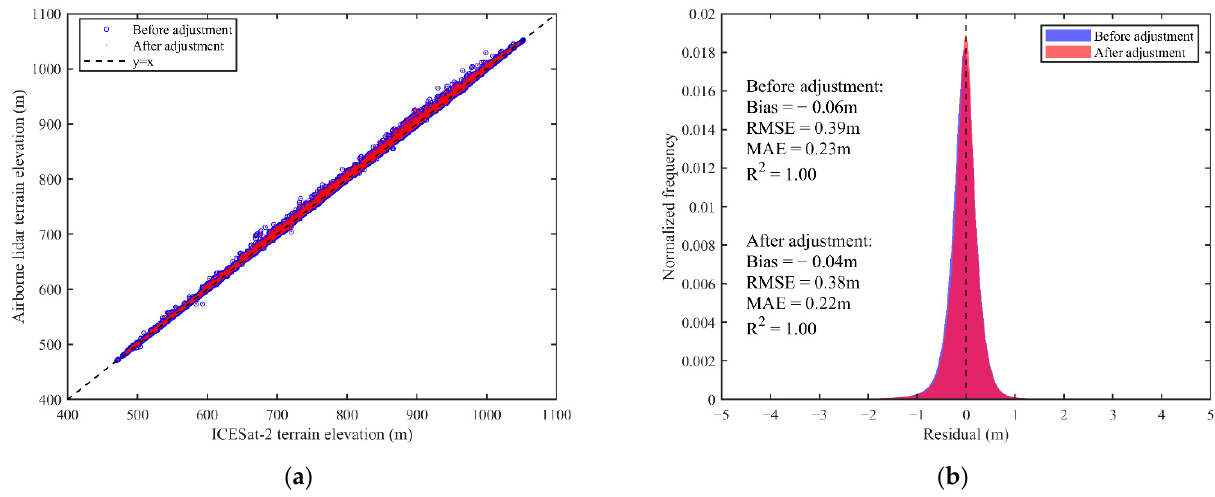
Figure 11. Overall agreement between ICESat-2 and airborne lidar terrain elevation. ( a ) Scatter plots of ICESat-2 and airborne lidar terrain elevation before and after adjustment; ( b ) histogram of ICESat-2 and airborne lidar terrain elevation residuals before and after adjustment.